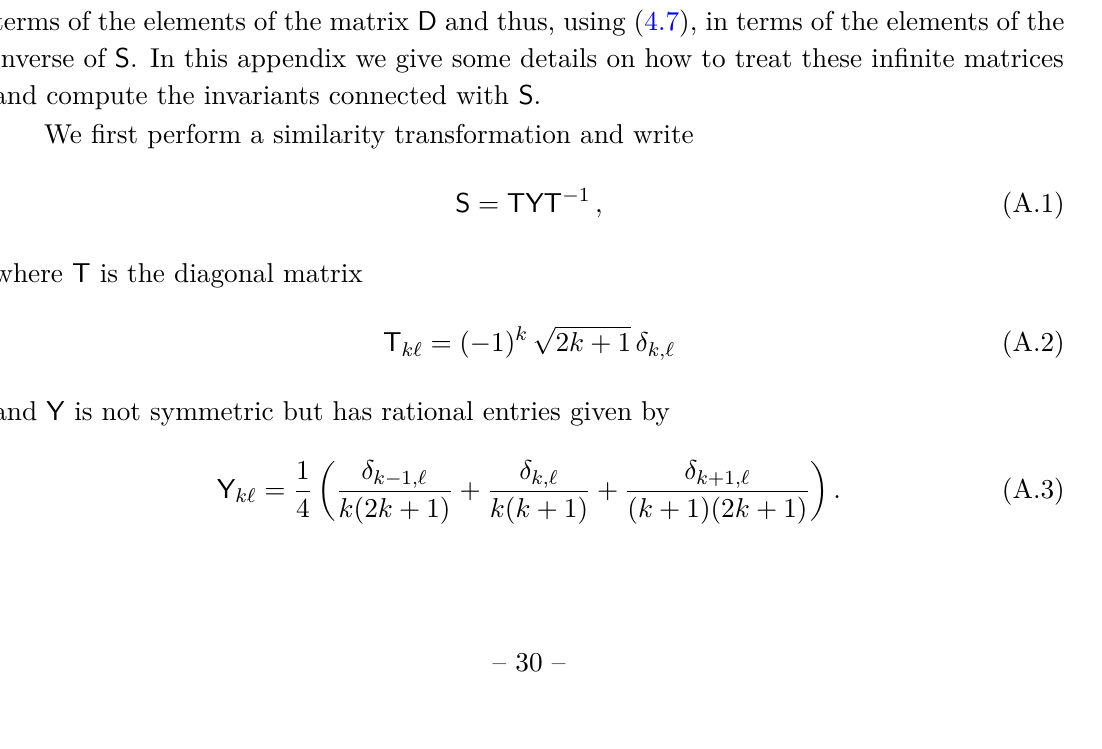
Figure 7 . Comparison between the diagonal Padé approximant P points and the functions q LO agreement between the Padé approximant P as shown in figure 6, the asymptotic regime becomes manifest only for larger values, i.e. λ ∼ 10 6 , we do not expect the expressions q LO 0 ≤ λ/π 2 ≤ 550 analyzed